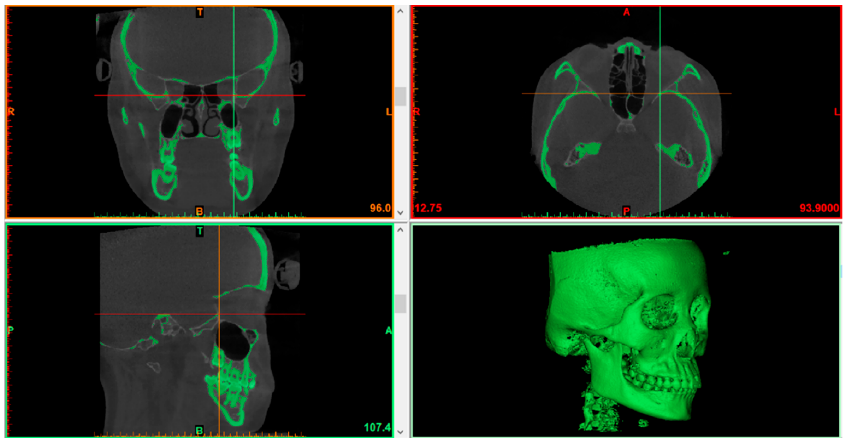
Figure 2. An initial segmentation mask from the CBCT data.